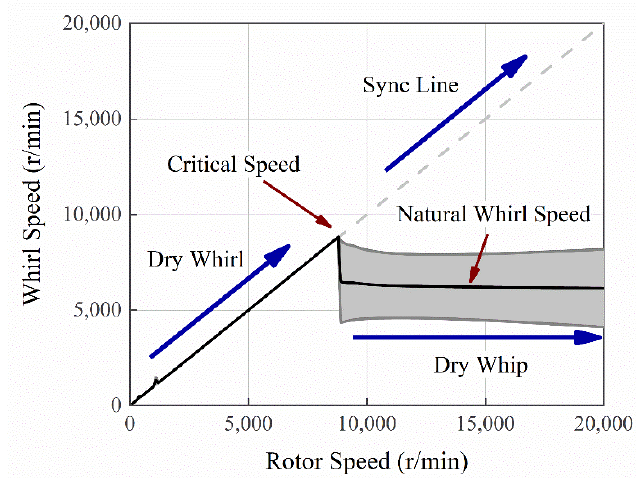
Figure 10. Whirl speed variation spectrum with initial touchdown speed.